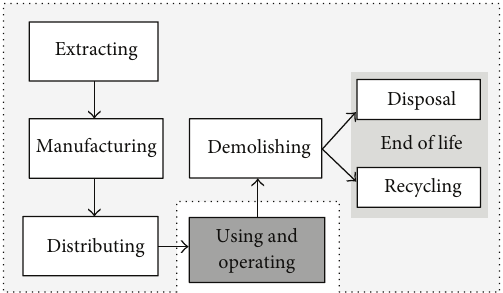
Figure 3: Layout of the system boundary